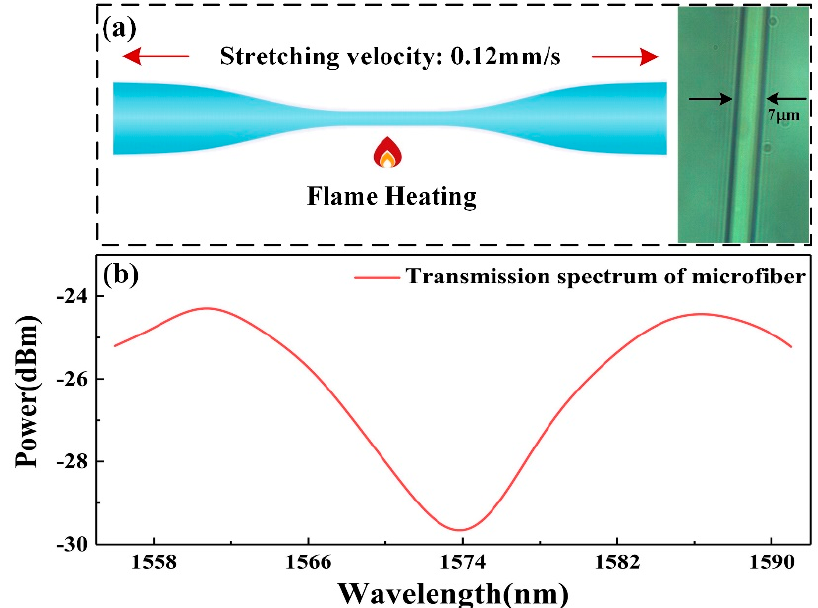
Figure 2. ( a ) Fabrication method and micrograph of microfiber and ( b ) the reflective spectrum of the microfiber in water.